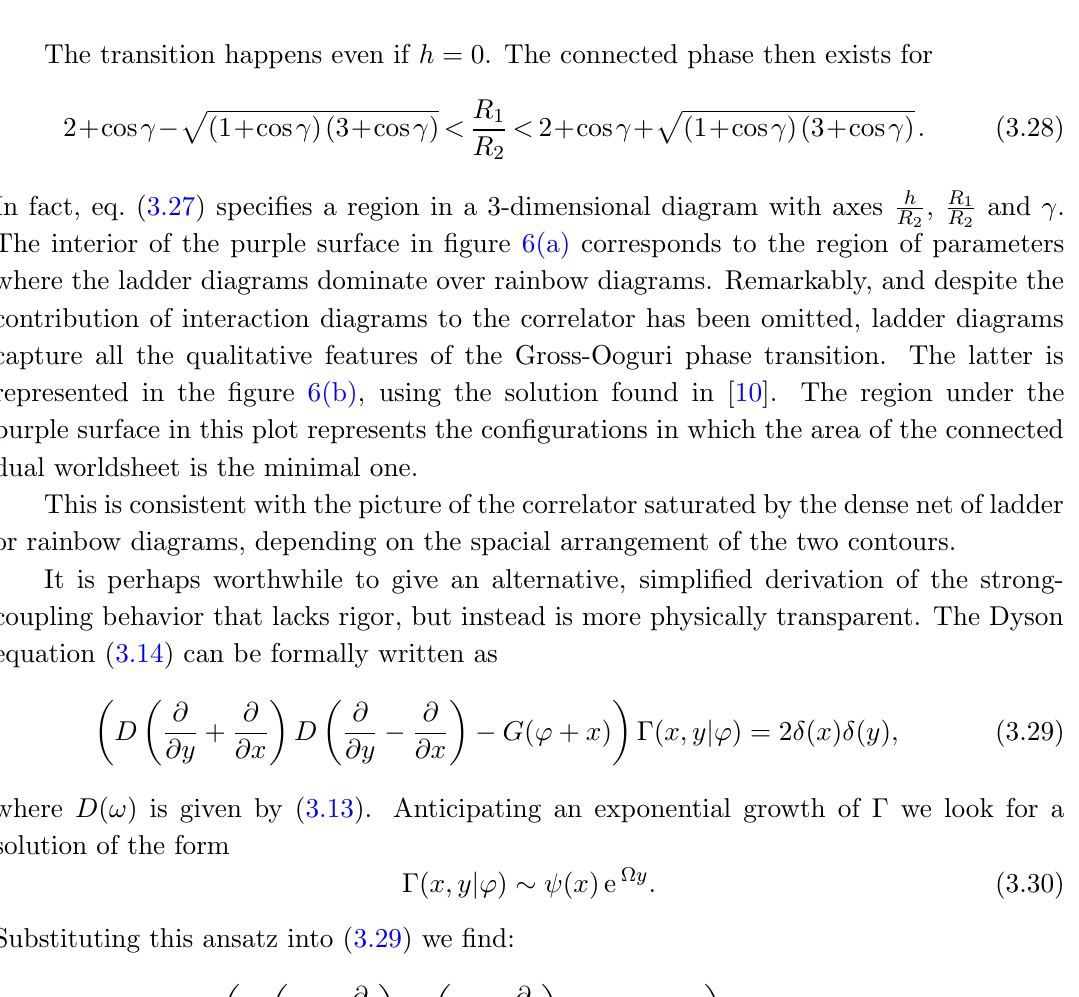
Figure 6 . Comparison between ladders contribution phase transition and the Gross-Ooguri phase